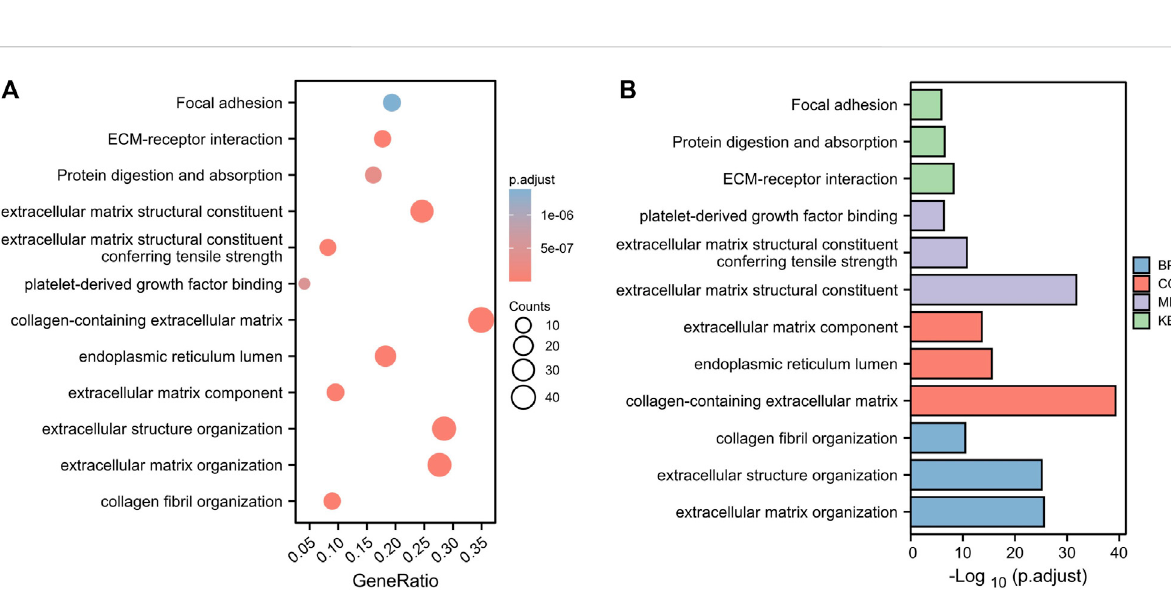
FIGURE 7 Functional analysis based on the DEGs between the two risk groups in the TCGA cohort. (A) Bubble diagram of GO and KEGG enrichment (the bigger bubble means themore genes enriched, and the increasing depth ofred meansthe differences were more obvious). (B) Bar plotgraph ofGO and KEGG enrichment (the longer bar means the more genes enriched, and the increasing depth of red means the differences were more